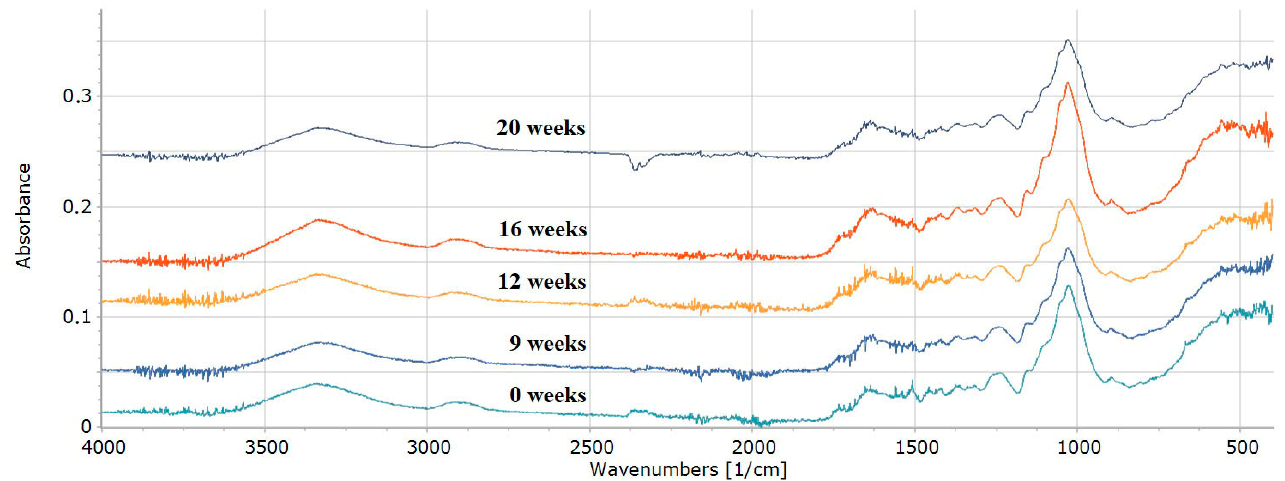
Figure 2. FTIR spectra for selected particleboard samples after 0, 9, 12, 16, and 20 weeks pretreatment with P. ostreatus.